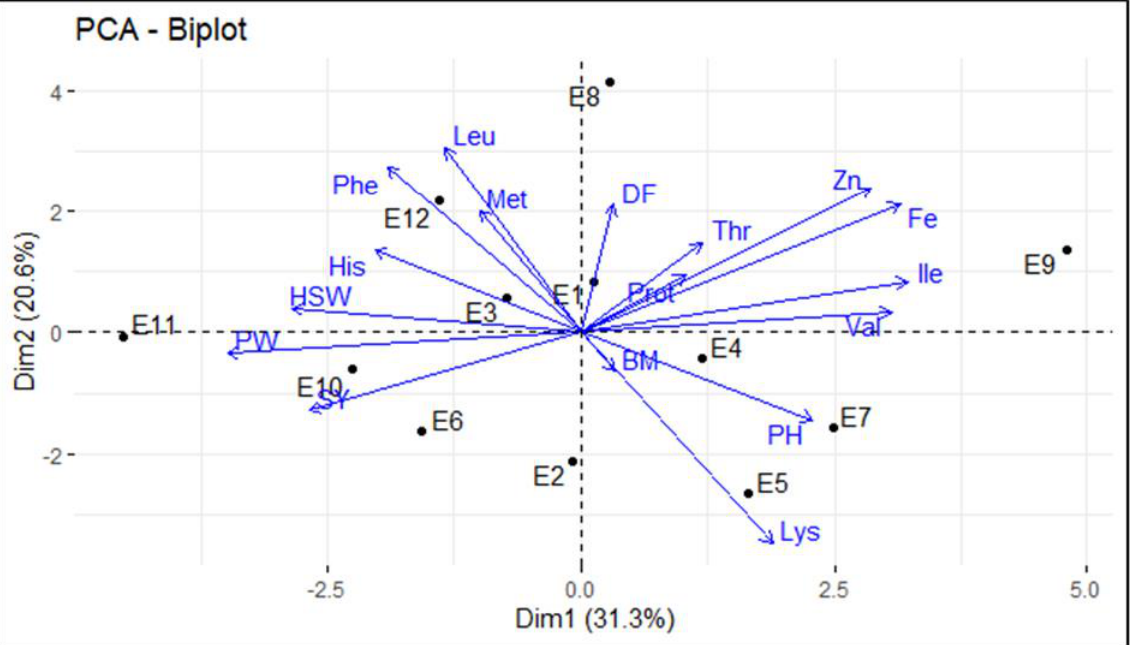
Figure 2. Principal component biplot showing the distribution and overall variation among 12 sor- ghum genotypes (denoted E1 to E12) based on combined agronomic and grain quality parameters. Note: see Table 1 for entry codes. His = Histidine; Ile = Isoleucine; Leu = Leucine; Lys = Lysine; Met = Methionine; Phe = Phenylalanine; Thr = Threonine; Val = Valine; Fe = Iron; Zn = Zinc; Prot = Pro- tein, DF = days to flowering, PH = plant height, BM = biomass, PW = panicle weight, SY = seed yield and HSW = hundred seed weight.